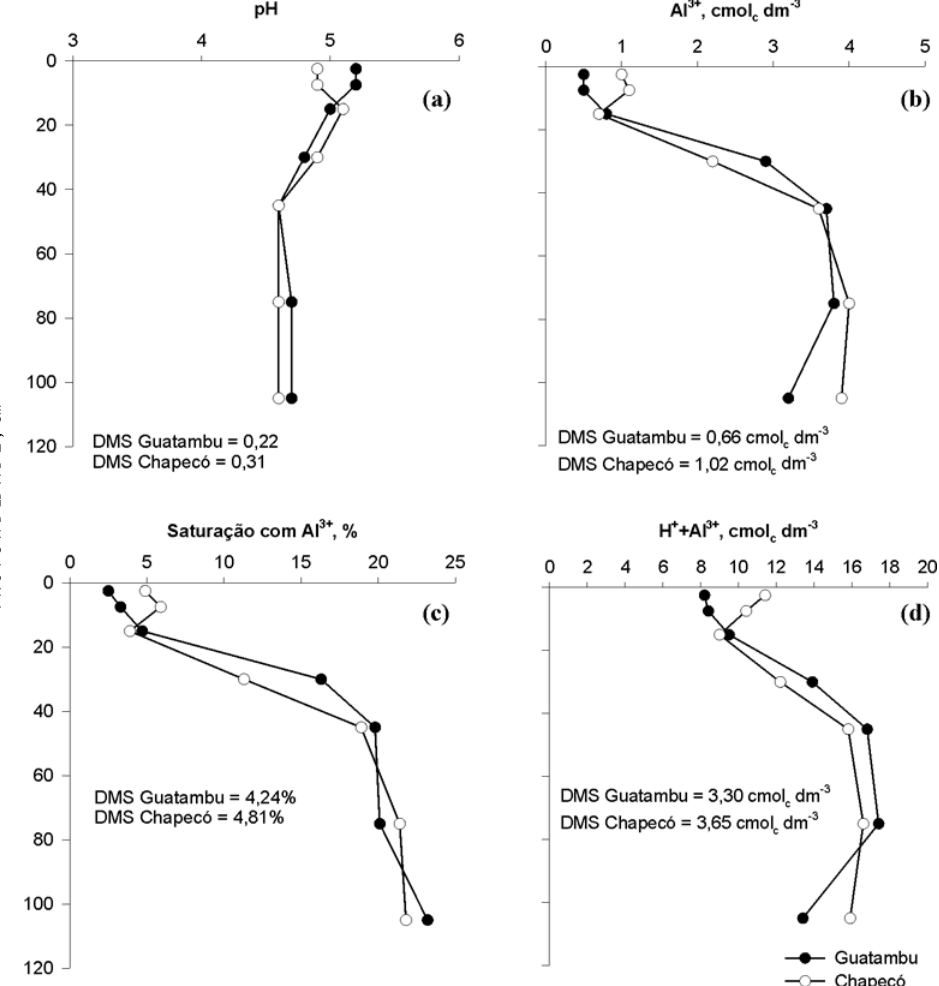
Figura 3. Valores de pH-H O (a), alumínio trocável (b), porcentagem de saturação com alumínio (c) e acidez 2 potencial (d) no perfil do solo, em diferentes profundidades, considerando a aplicação de esterco de suínos por três anos em Guatambu e quatro anos em Chapecó. DMS = diferença mínima significativa entre profundidades para o teste de Tukey a 5